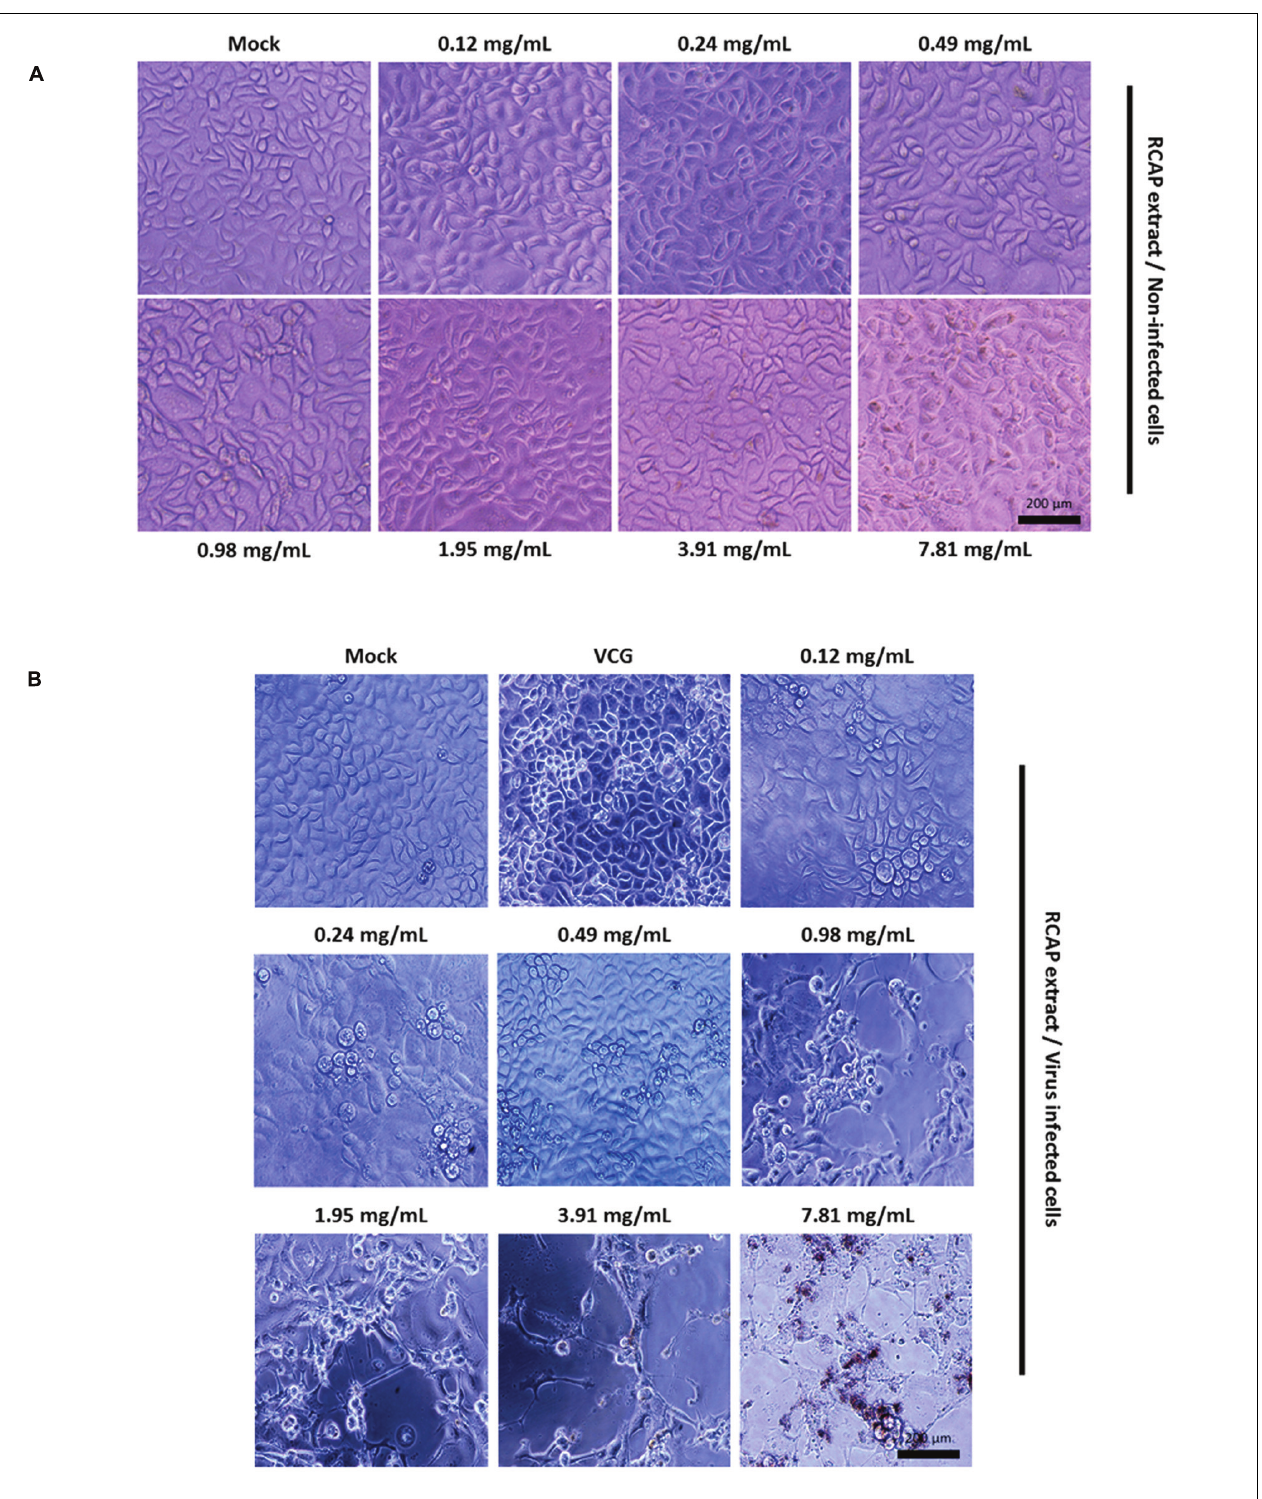
FIGURE 2 | Morphological observation of MA-104 cells in antiviral assay. (A) Non-infected cells incubated with RCAP extract; (B) Rotavirus-infected cells treated with RCAP extract. Morphological changes were characterized by rounding and enlargement of the cells and by detachment of the cells from the substrate.